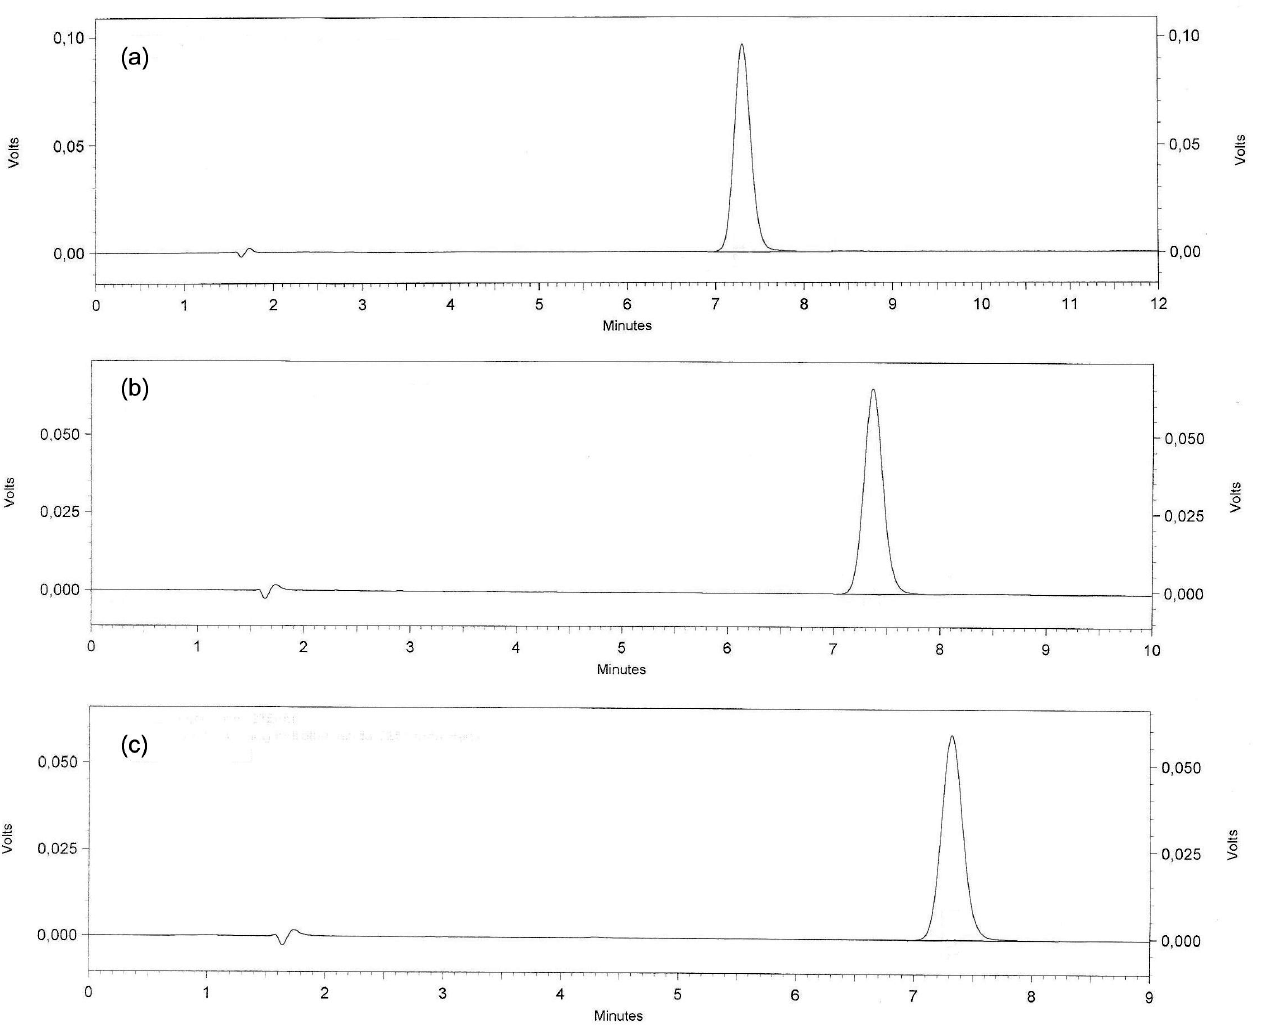
FIGURE 2 - Chromatograms corresponding to: (a) solution of DP reference substance time zero, (b) solution of DP reference substance time 5 hours and (c) solution of DP reference substance time 24 hours after acid hydrolysis